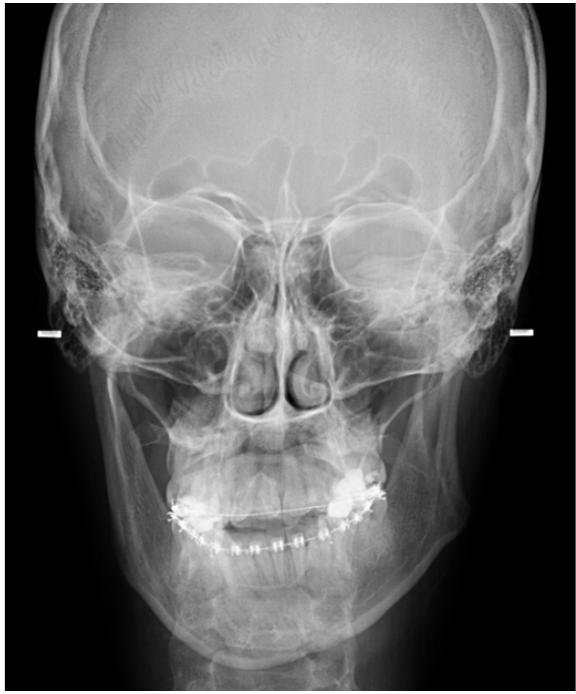
Figure 3. A classical P- A mandible radiograph.